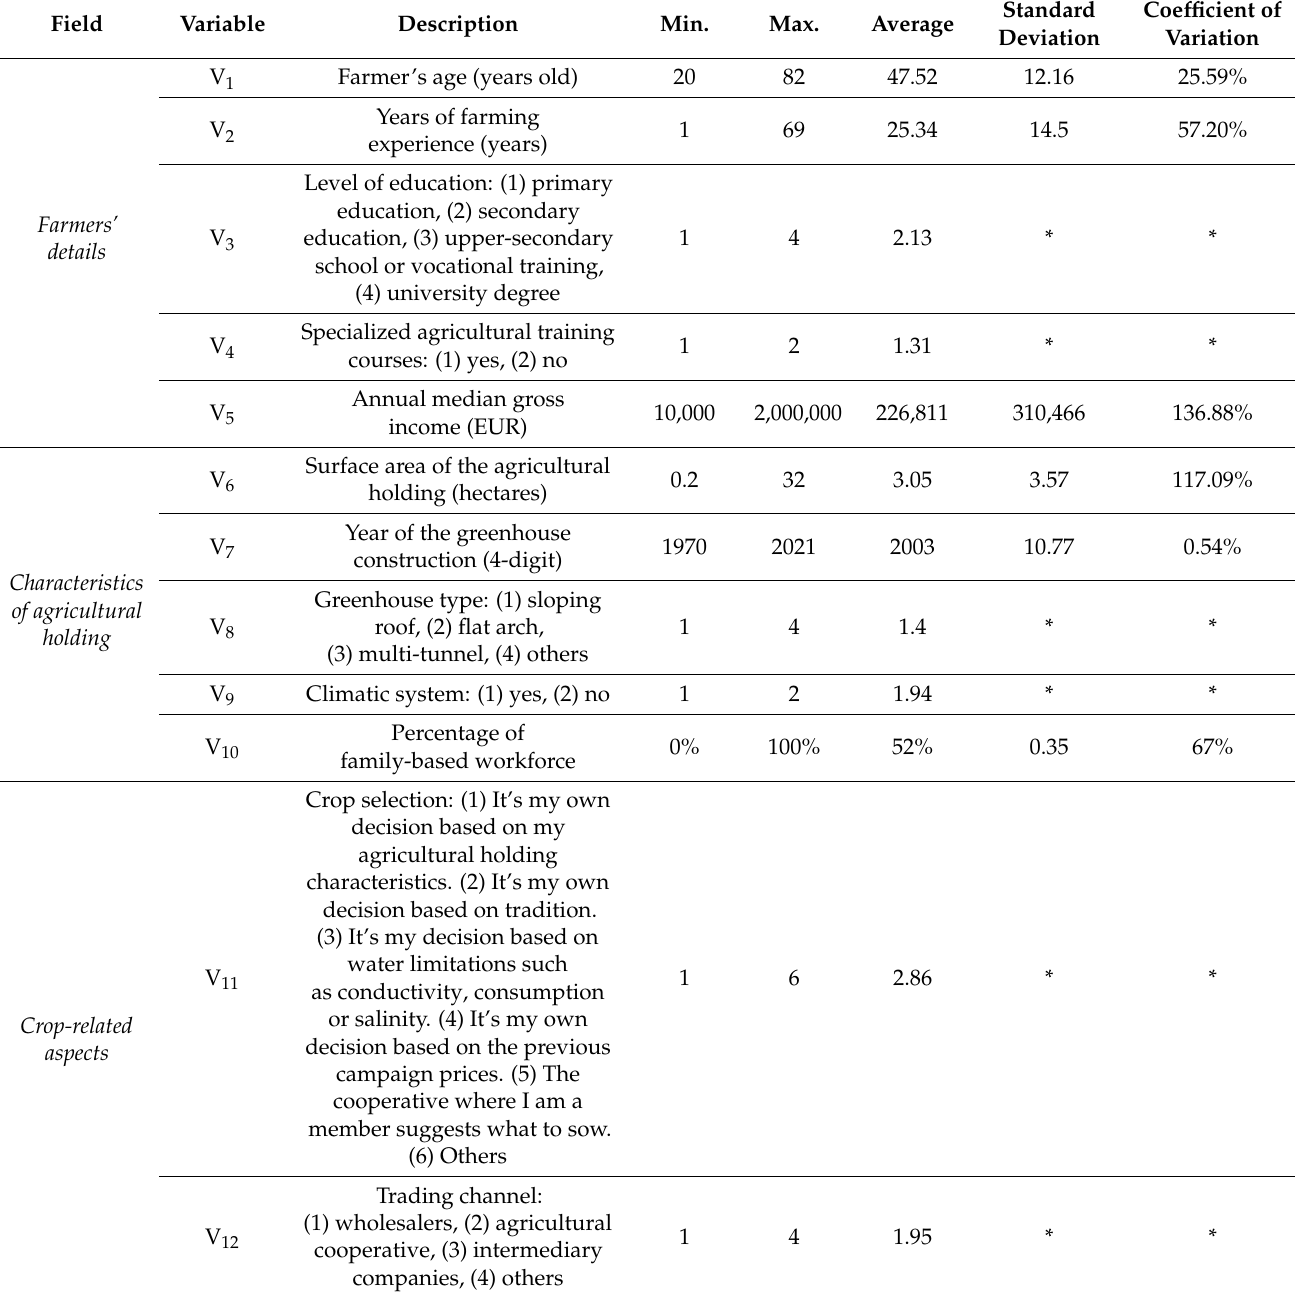
Table 1. Features of farmers surveyed and their agricultural